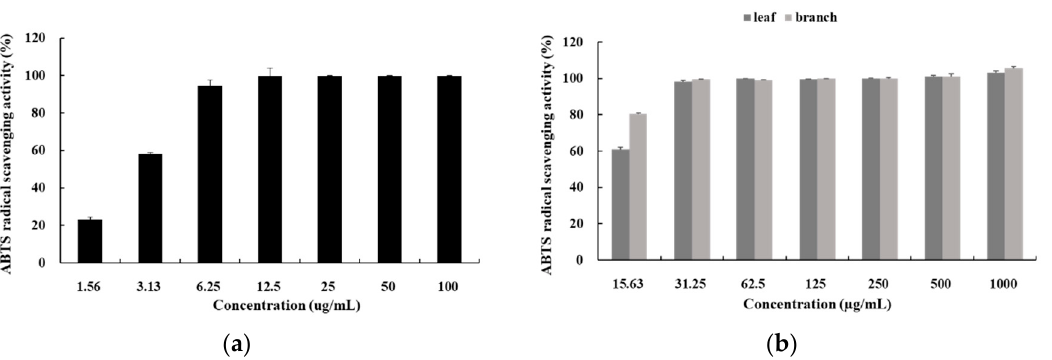
Figure 2. ABTS (2,2’-azino-bis(3-ethyl-benzthiazoline-6-sulfonic acid)) radical scavenging activities of ( a ) L-ascorbic acid and ( b ) hot-water extracts from S. samarangense . An appropriate amount of ascorbic acid was used as a positive control. The results were expressed as the mean ± SD of data obtained from three independent experiments.